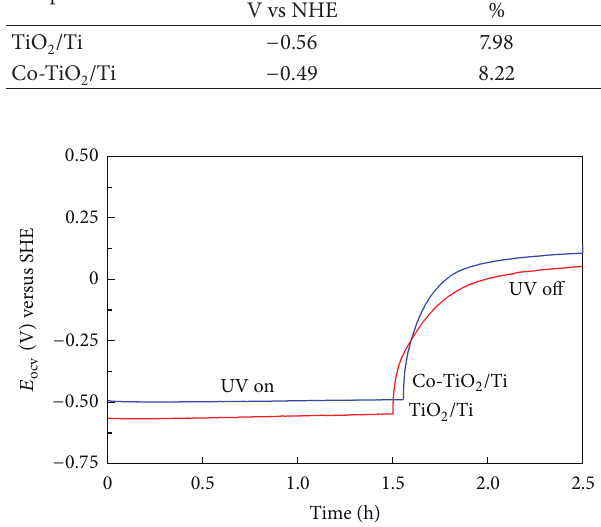
Figure 5: Open-circuit potential at UV on and off for TiO 2 /Ti (red) and Co-TiO 2 /Ti (blue).